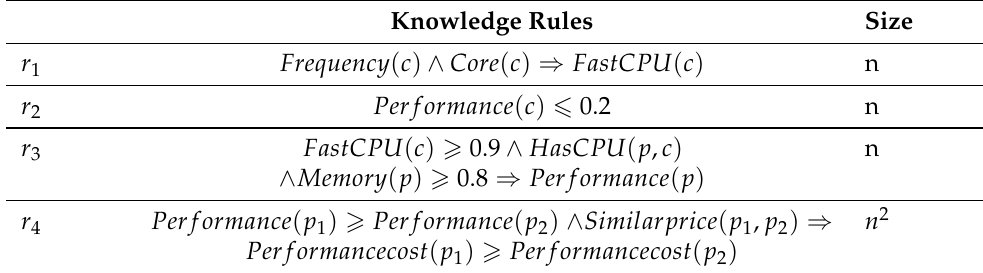
Table 1. Examples of knowledge